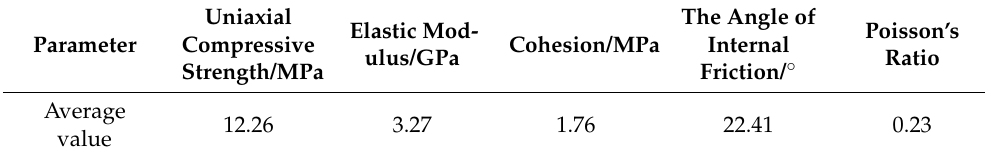
Table 2. The basic mechanical parameter values of the raw lean